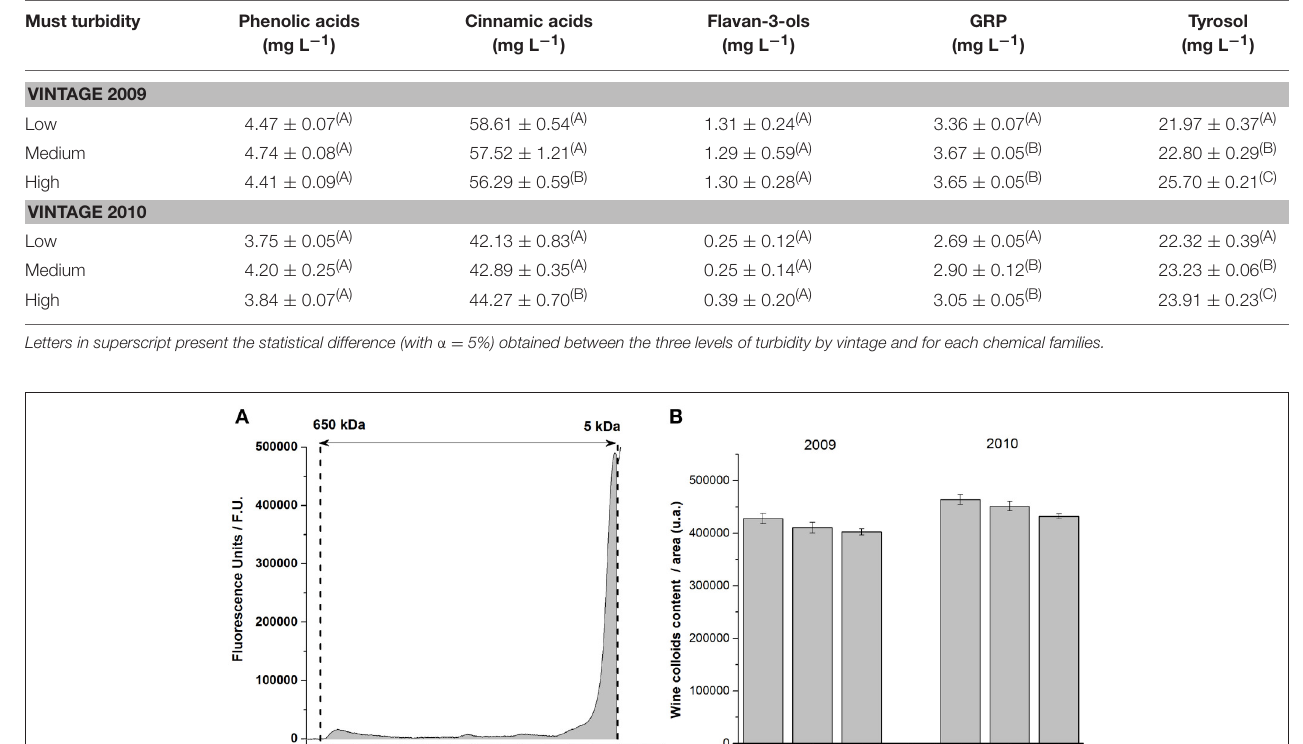
turbidities (low and high) used for white wine elaboration